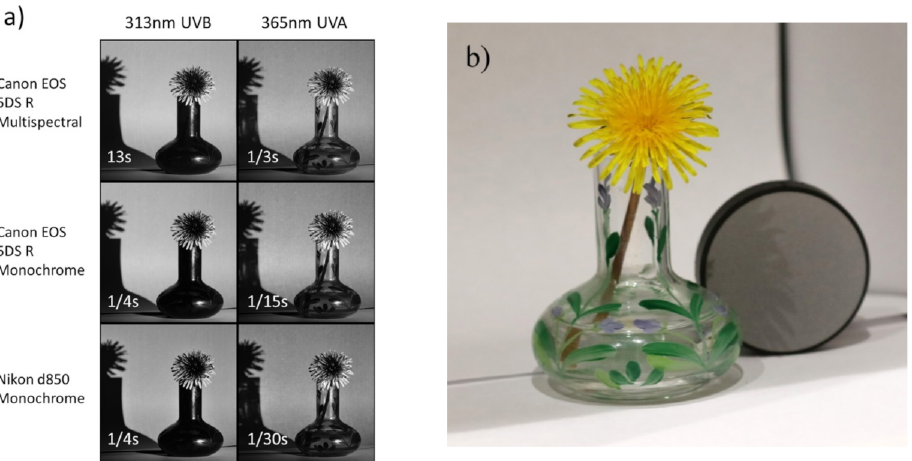
Figure 5. Images of a common dandelion ( Taraxacum officinale ) taken in ( a ) UVA (365 nm) and UVB (313 nm) with the test cameras and including exposure times; ( b ) visible light image of the subject and diffuse reflectance